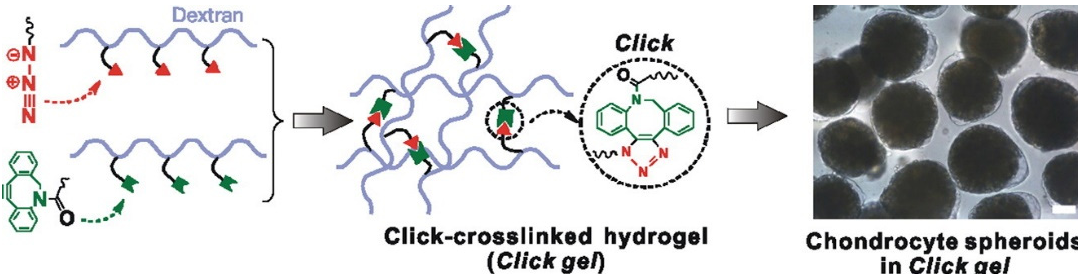
Figure 8. Injectable dextran-based hydrogels crosslinked by metal-free click chemistry [110].